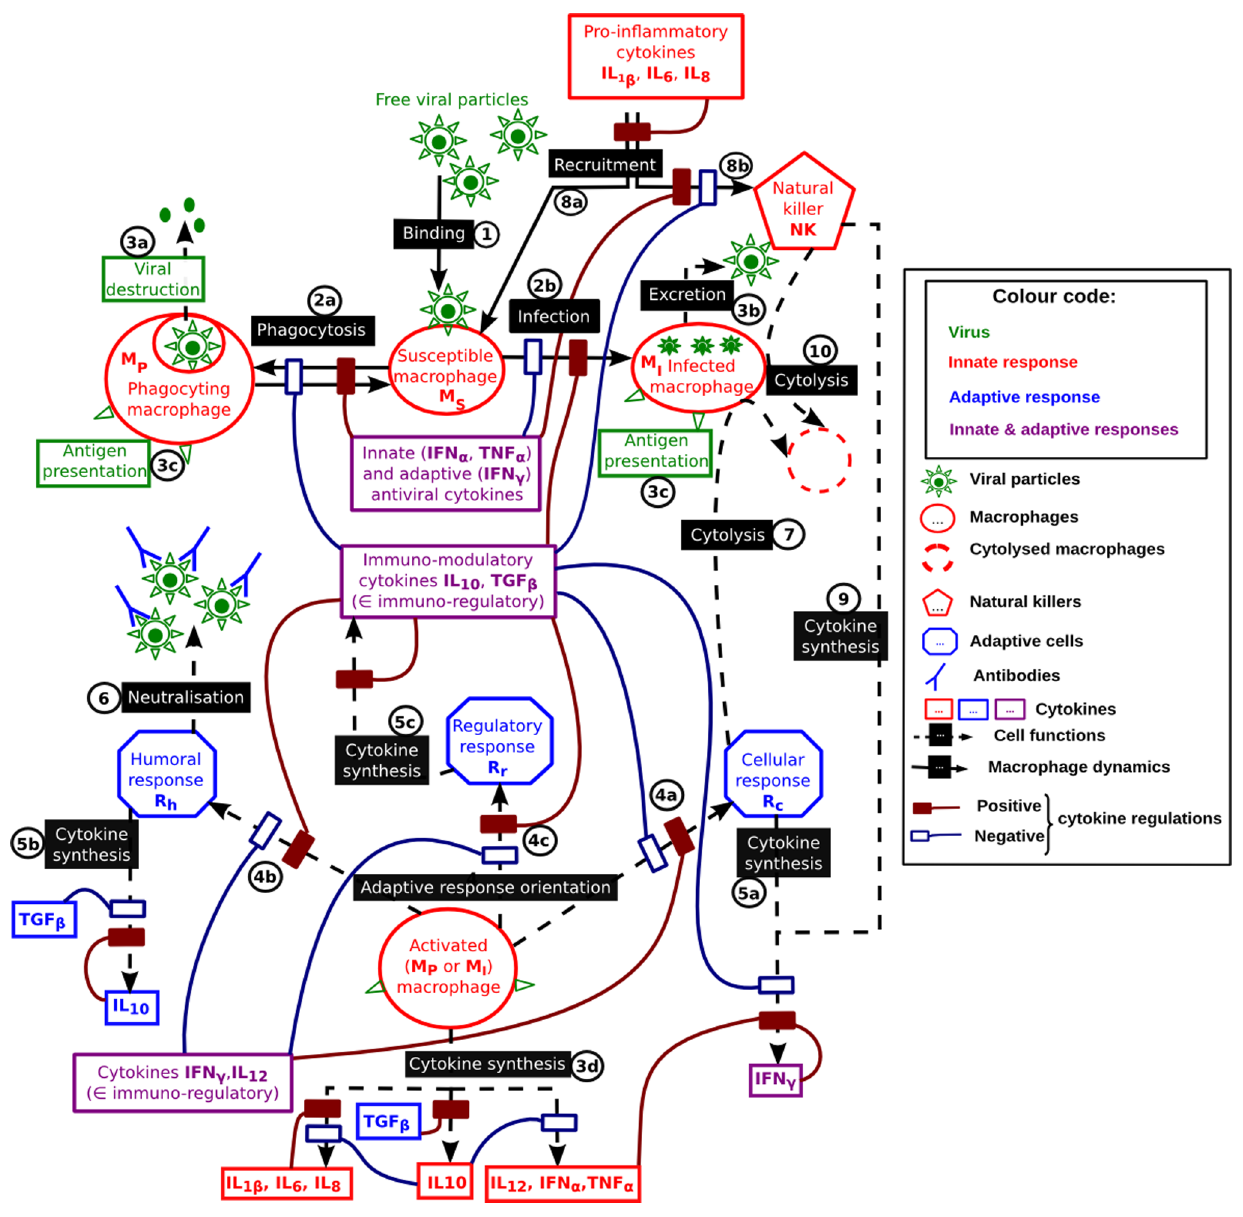
Figure 1. Functional diagram of the immune response to a virus targeting macrophages. Interactions between macrophages and virus (1) result in macrophage activation by either phagocytosis (2a, amplified by antiviral cytokines and inhibited by immuno-modulatory cytokines) or macrophage infection (2b, amplified by immuno-modulatory cytokines and inhibited by antiviral cytokines) releasing viral particles (3b). The activated macrophages initiate the adaptive response (4a–c). IFN c and IL 12 orient the adaptive response towards the cellular response (4a), whereas immuno- modulatory cytokines orient the response towards the humoral and regulatory responses (4b–c). The cellular response and the natural killers are responsible for the destruction of infected cells by cytolysis (7 & 10, respectively). The humoral response is responsible for the viral neutralisation through antibodies (6). The recruitment of susceptible macrophages and natural killers is amplified by the pro-inflammatory cytokines (8a & 8b, respectively). Cytokines are produced by activated macrophages (3d), natural killers (9) and adaptive cells (4a–c). These syntheses are regulated by various cytokines. Figure 1). The phagocytosis is amplified by antiviral cytokines Table 1. A complete description of the model and the corresponding equations is given in Appendix S1. Here we describe the main ( TNF a , IFN a and IFN c ) and inhibited by immuno-modulatory components of the model, illustrated by a few representative equations. cytokines ( IL 10 and TGF b , 2a in Figure 1). The infection (linked to the macrophage permissiveness) is amplified by IL 10 and inhibited by innate antiviral cytokines ( IFN a ,TNF a ) and TGF b (2b in 1). Phagocyting macrophages revert to a susceptible status after viral destruction (rate c ); it is amplified by the antiviral